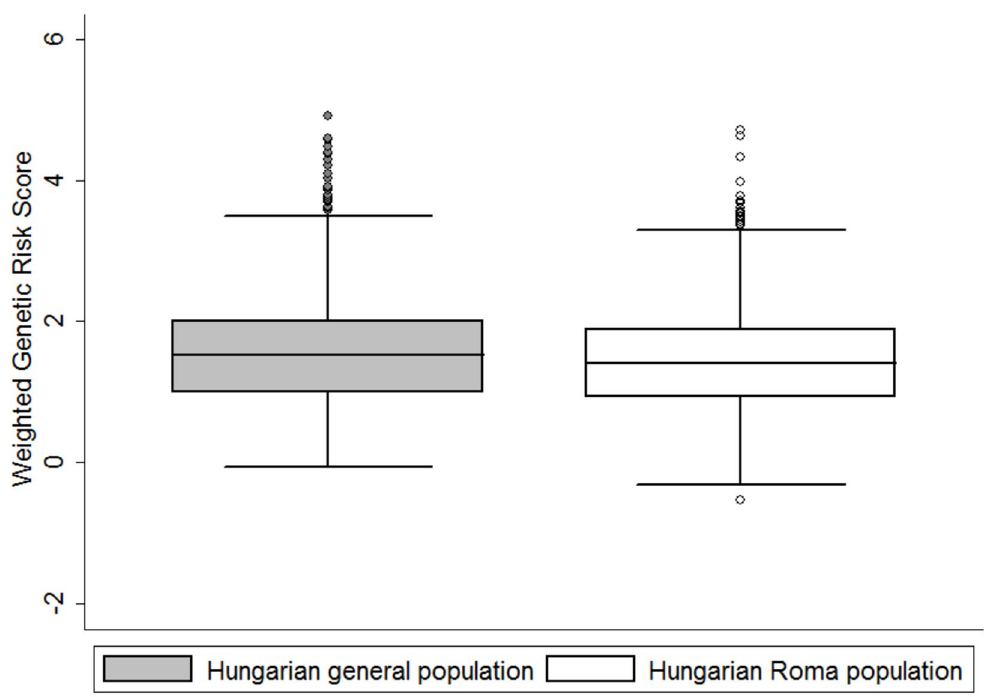
Fig 3. Distributions of wGRSs in the HG (grey) and HR populations (white) were significantly different (p <